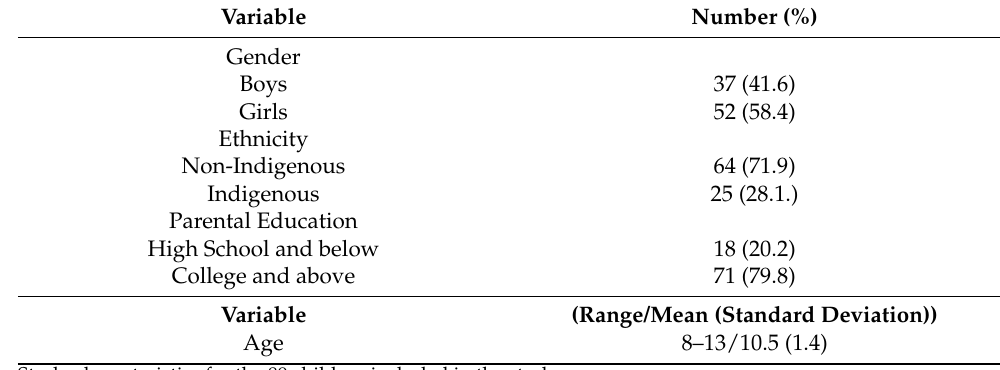
Table 1. Sociodemographic characteristics.